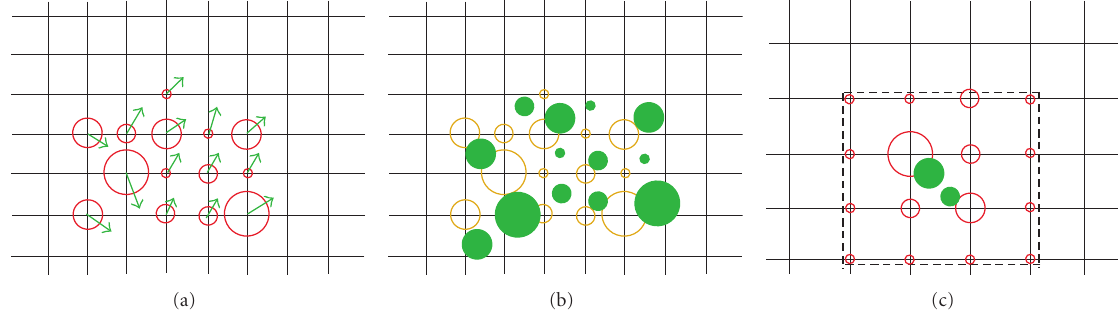
Figure 2: Particles interpolation scheme. The circle’s size denotes the strength of the particle, and the solid circles represent the advected particles. (a) Vortex particles and velocity field; (b) advection step; (c) remesh-di ff usion